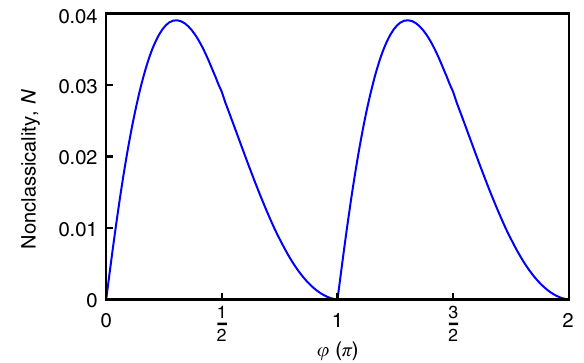
Fig. 1 The nonclassicality of the qubit pure dephasing. We consider the qubit pure dephasing reduced from the extended spin-boson model, wherein φ (in unit of π ) is the relative phase between the coupling constants of the qubit-pair to the common boson environment. The nonclassicality N is quanti fi ed according to Eq. (4). In this example,